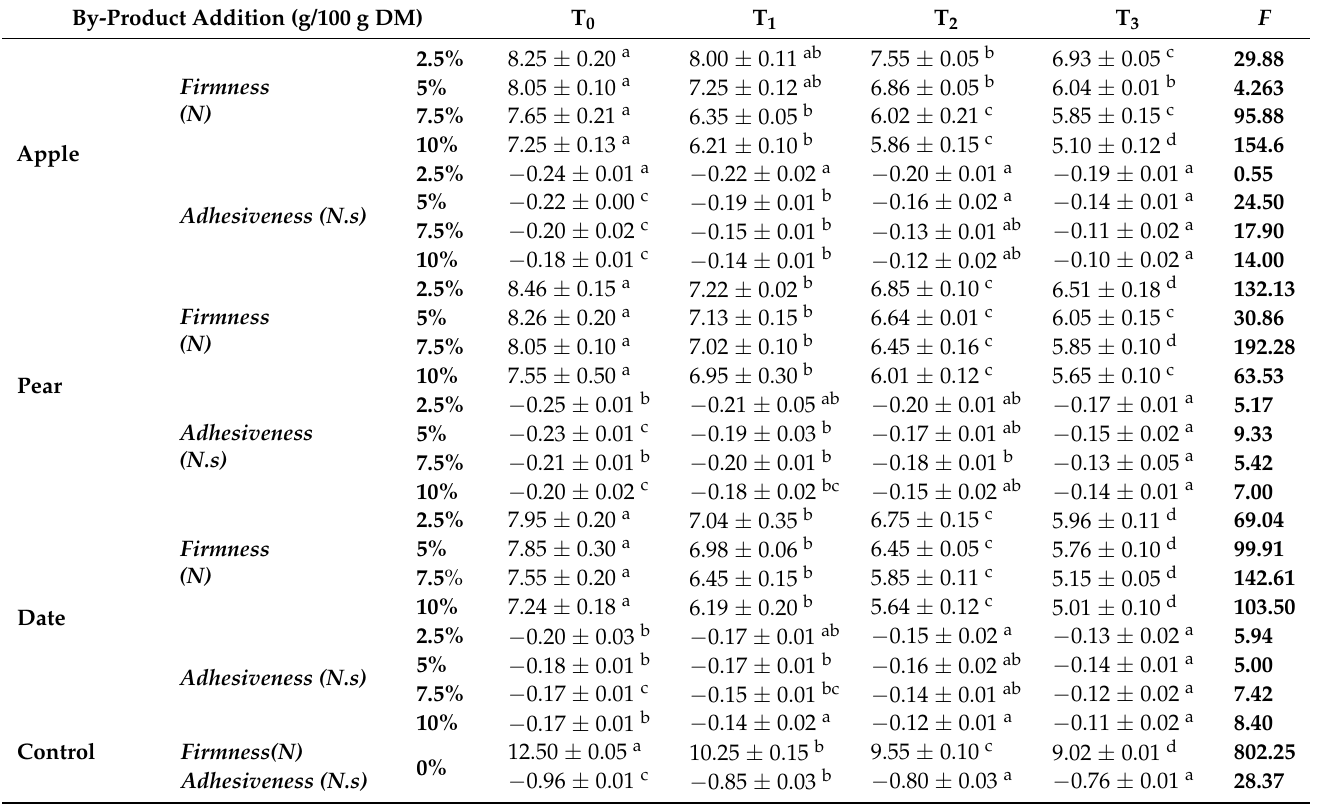
Table 3. Firmness and adhesiveness of cooked pasta made with added apple, pear, and date